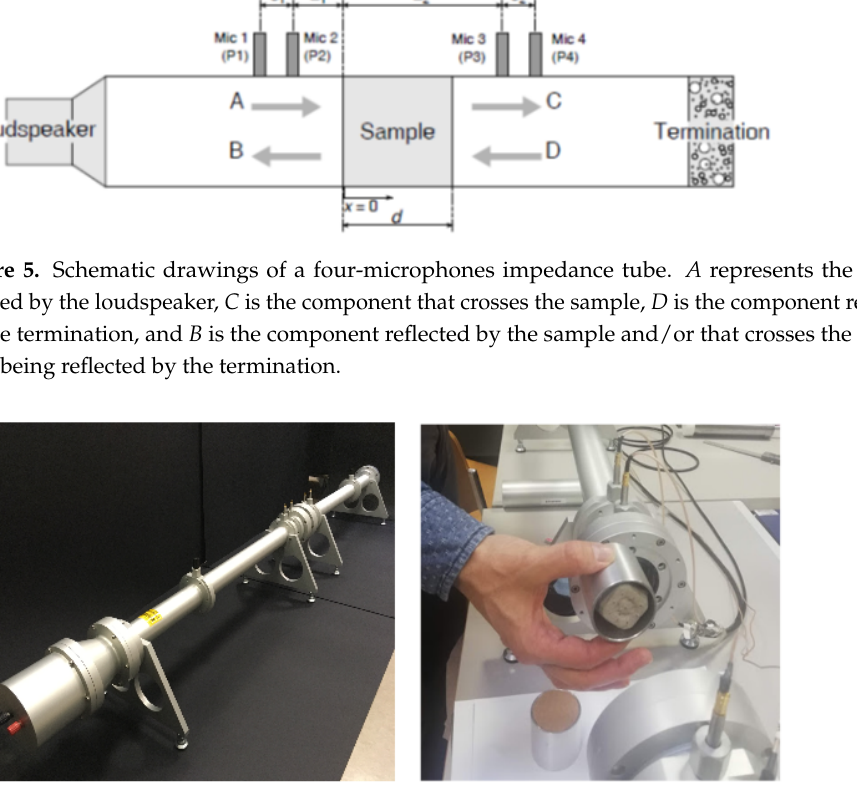
Figure 6. Impedance tube used for the determination of the acoustic properties of